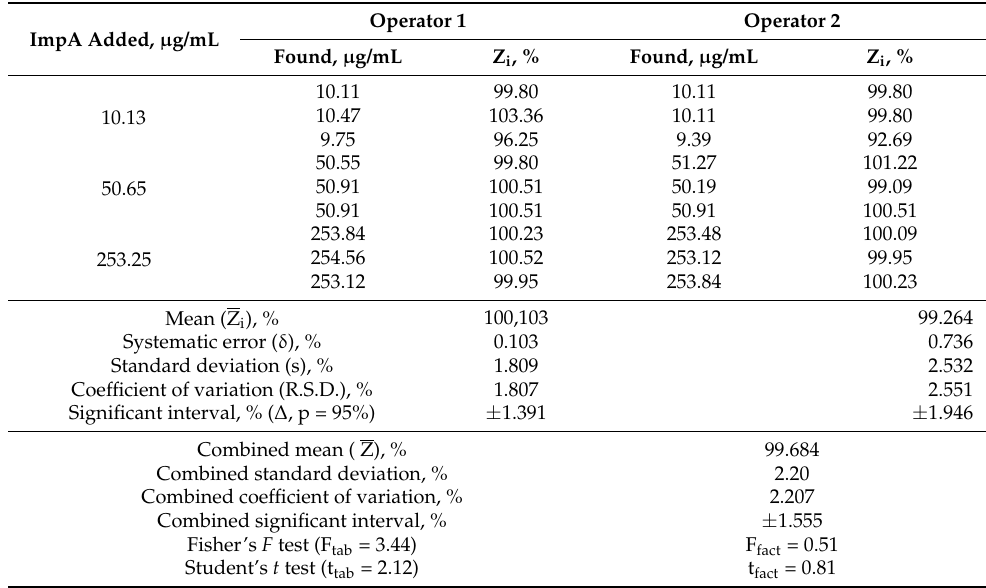
Table 4. Results of convergence and intralaboratory precision studies of the method being validated. ImpA Added, µ